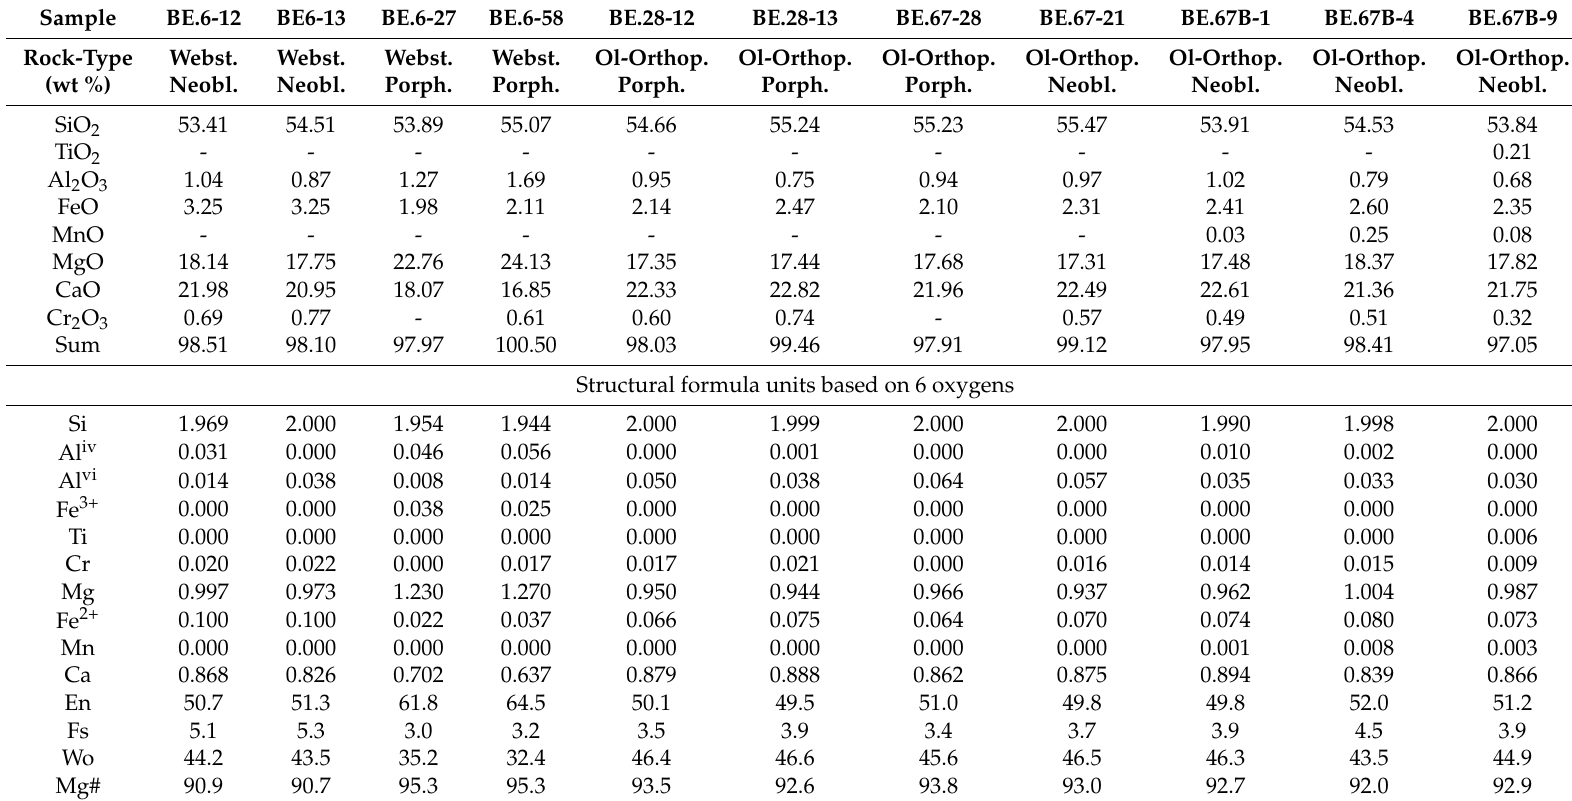
Table 2. Representative electron microanalyses of clinopyroxenes from the Veria-Naousa pyroxenites (Porph.: porphyroclast, Neobl.: neoblast, -: below detection